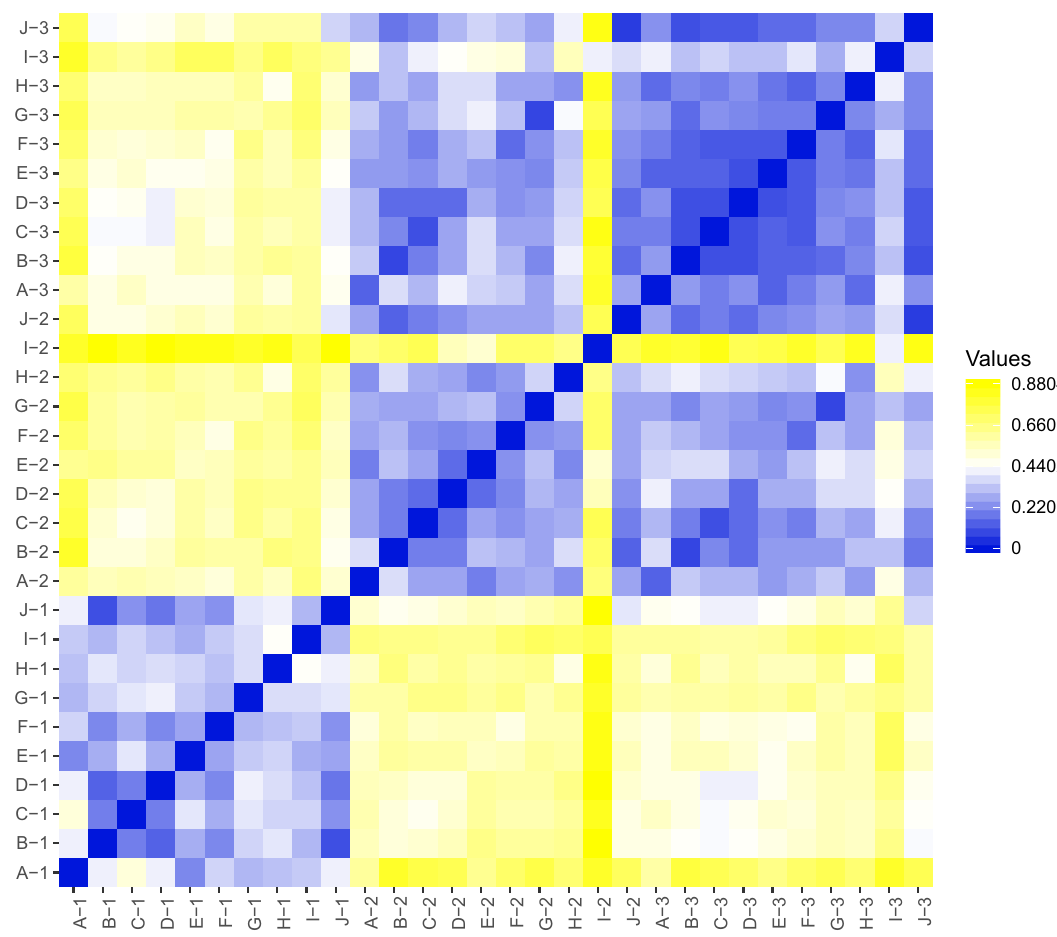
Figure 5. Comparison of relative abundance of bacterial composition between three primer sets amplifying 16S rRNA based on Spearman rank correlation coefficient. The most similar results are obtained with the primer set#2 and primer set#3. For the analysis 244 the most abundant bacterial genera and inclusion criteria for their presence in all samples was